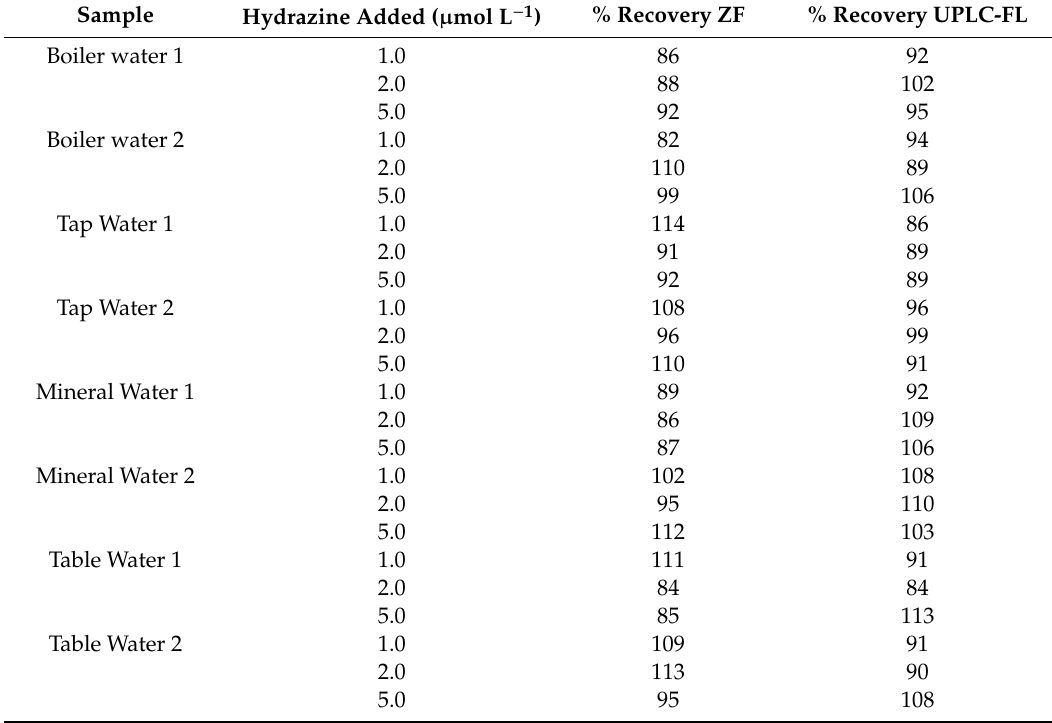
Table 3. Accuracy of the ZF